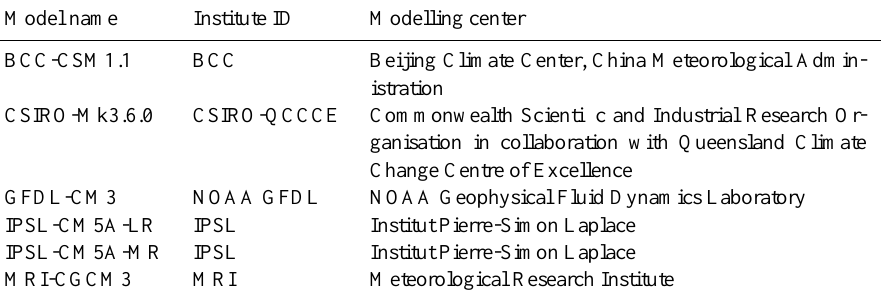
Figure 9. Ice concentration trends over the period 1979-2005 in historical simulations performed with CGCMs in the framework of CMIP5. Only the simulations characterized by an increase in sea ice extent over this period are represented here. The trends are scaled to represent 27 year changes. The name of the model (Table 3) and the corresponding member of the ensemble (if several members are available in CMIP5 archive) are mentioned on the top of each panel. Table 3. Model name and modelling centre corresponding to the CGCMs used to study the trend in sea ice extent over the period